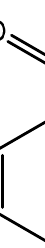
Figure 6. Illustrated structure of the magnesium bis -mandalate dihydrate structure proposed by Schmidbaur et al. [91].